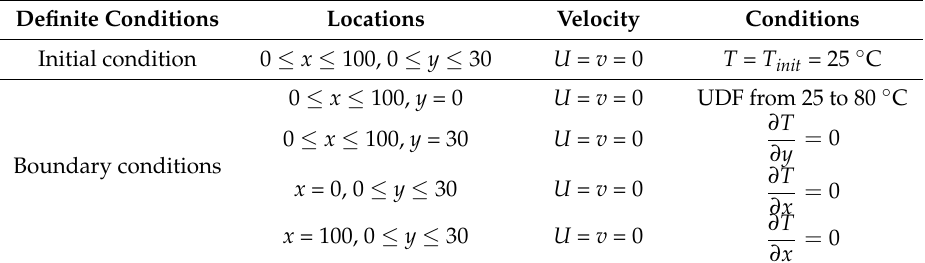
Table 2. The initial and boundary conditions. UDF—user defined function.